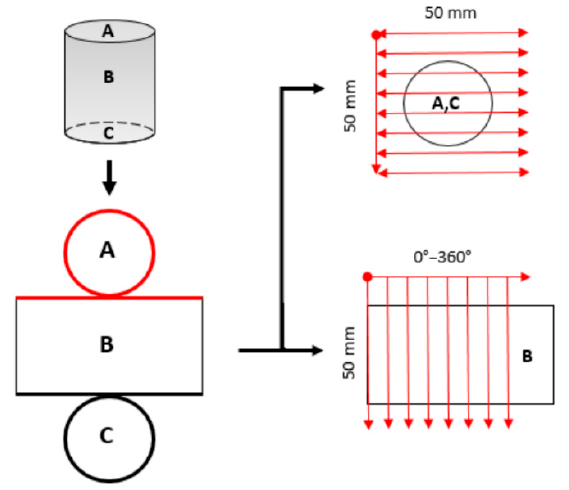
Figure 7. Procedure for scanning individual surfaces of biomaterial specimens for deformation influence experiment.